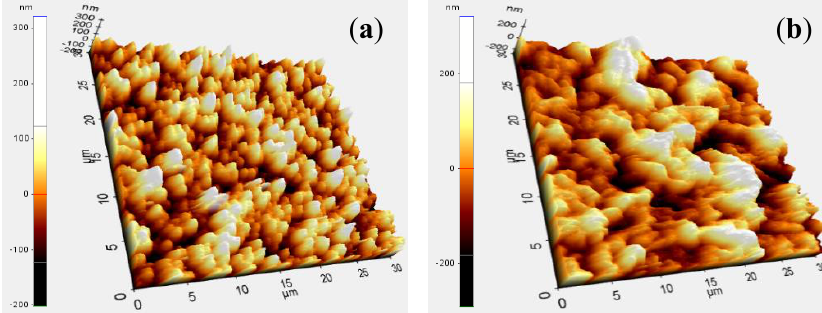
Figure 4. AFM images of the SSRE showing its surface morphology. Images ( a ) and ( b ) show the morphology before and after the electrode was coated with GO, respectively.